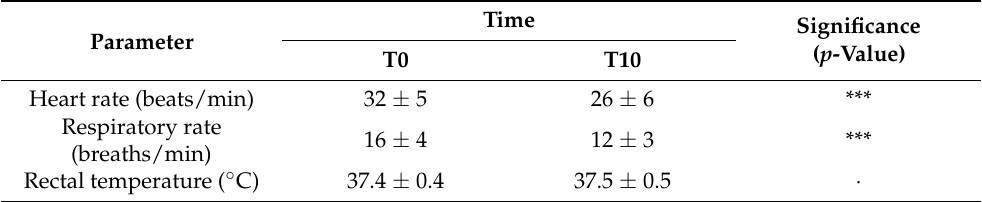
Table 4. Results of overall physiological parameters recorded in horses included in the study. Values were recorded at baseline (T0) and ten minutes after premedication (T10). Values are mean ± SD. Time Significance Parameter ( p -Value)T0 T10 Heart rate (beats/min) 32 ± 5 26 ± 6 *** Respiratory rate 16 ± 4 12 ± 3 *** (breaths/min) Rectal temperature ( ◦ C) 37.4 ± 0.4 37.5 ± 0.5 ·